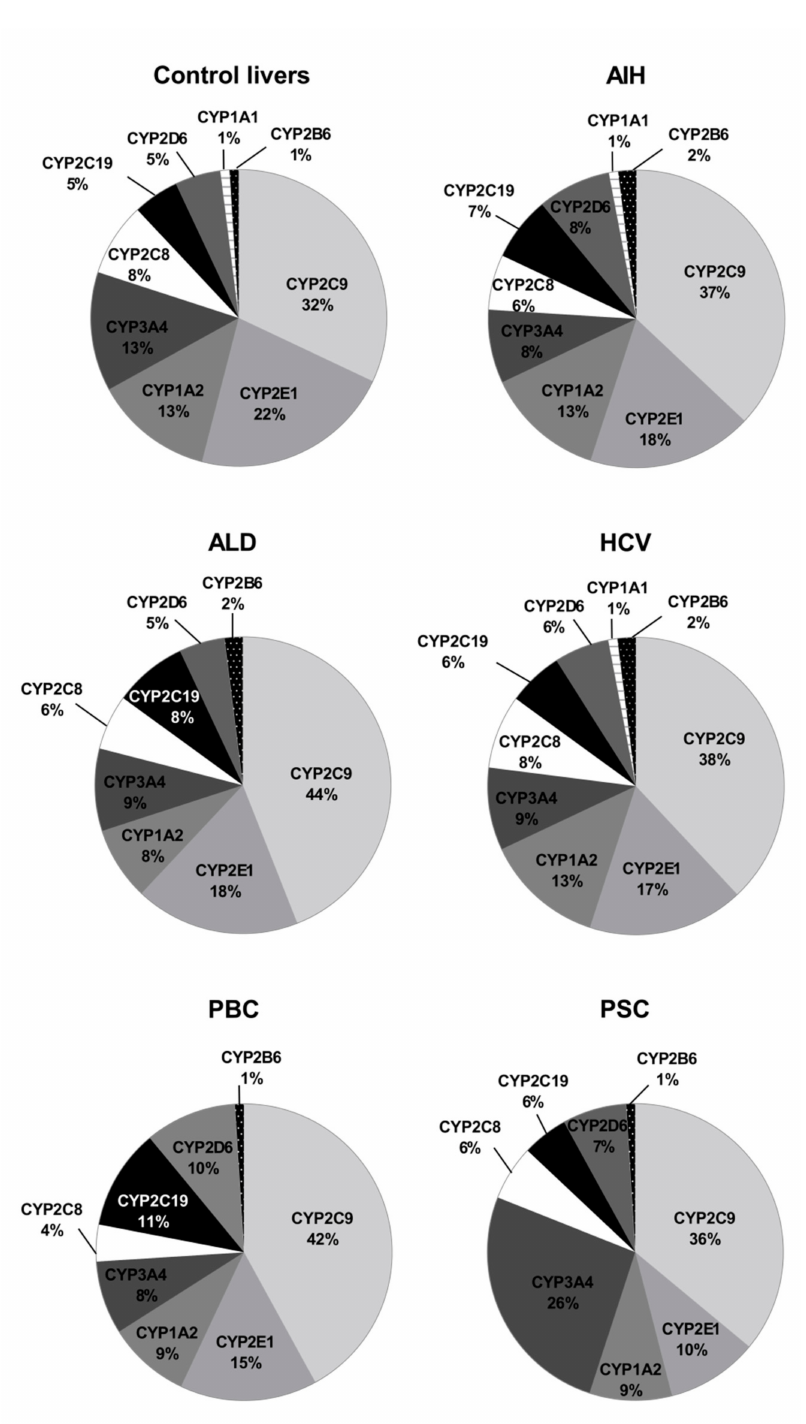
Figure 6. The pie chart of the individual enzyme proteins in livers tissues from hepatitis C (HCV), primary biliary cholangitis (PBC), primary sclerosing cholangitis (PSC), alcoholic liver disease (ALD) and autoimmune hepatitis (AIH) patients and the controls. The pie charts show the abundance of each enzymatic protein as a percentage of the sum of all enzyme proteins